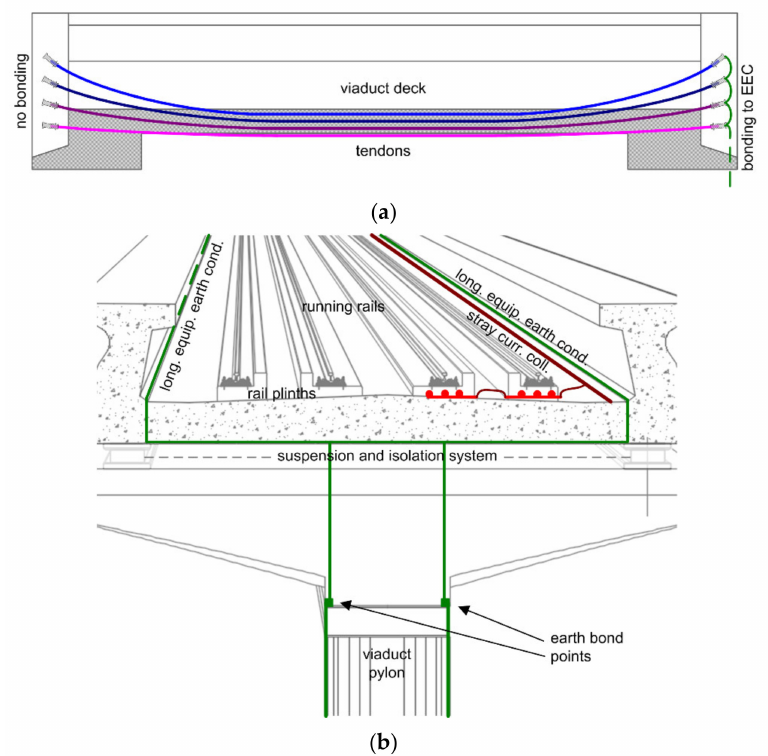
Figure 1. Details of ( a ) a viaduct span with tendons (earthed at one end only), ( b ) a viaduct deck and pylon with sketch of the earthing system (in dark green) and of the stray current protection system (SCPS) (in red for stray current drainage (SCD) elements, in brown for the bonding connection and stray current collector